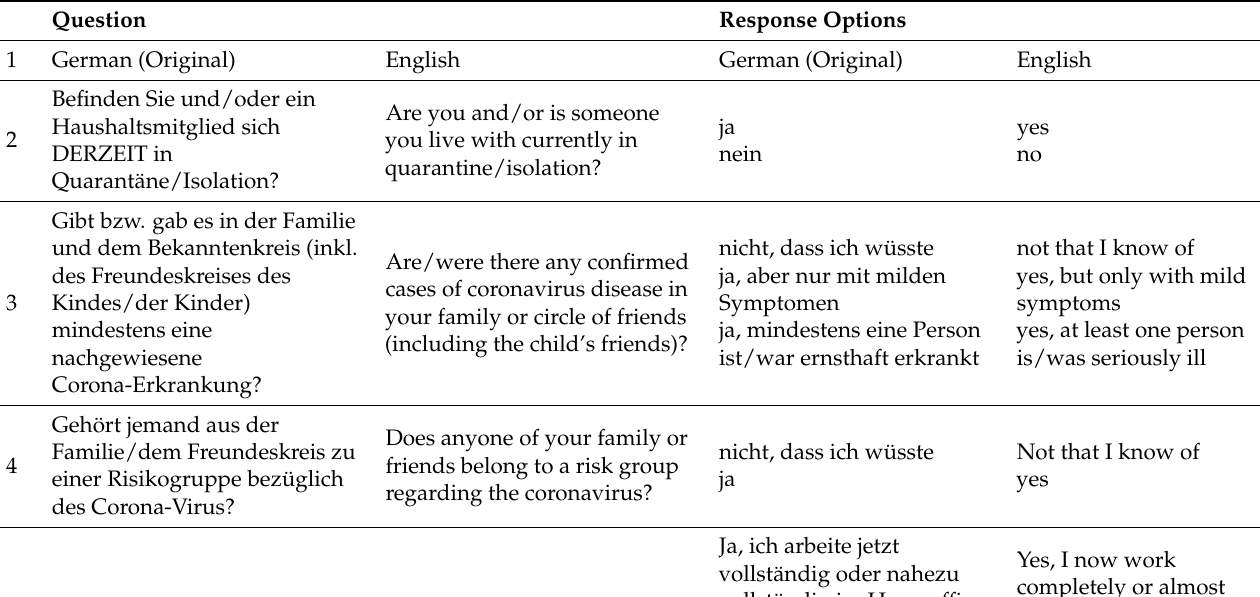
Table A1. Questionnaire on COVID-19-related attitudes and